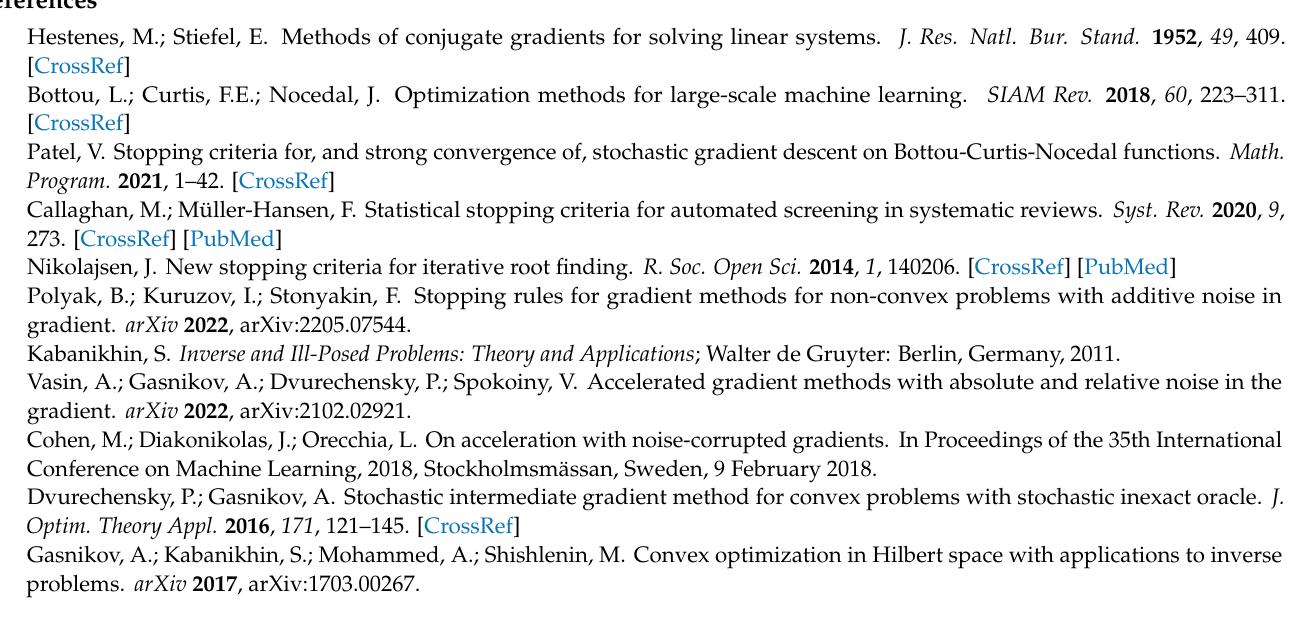
Figure 6. ( a ) Graph of x res n depending on the component index n . ( b ) Graph of the iteration number s